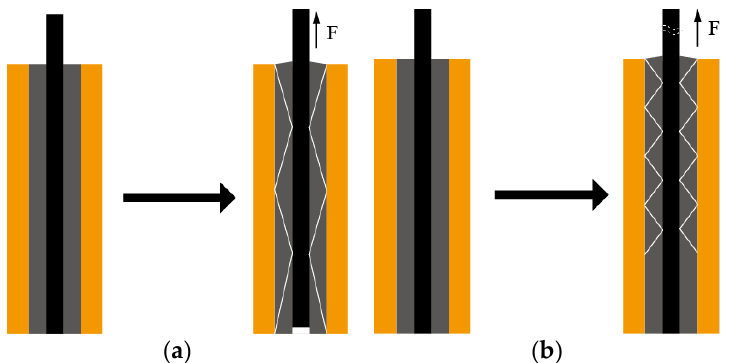
Figure 15. Load displacement curve of the bar excluding the bar body deformation of free section